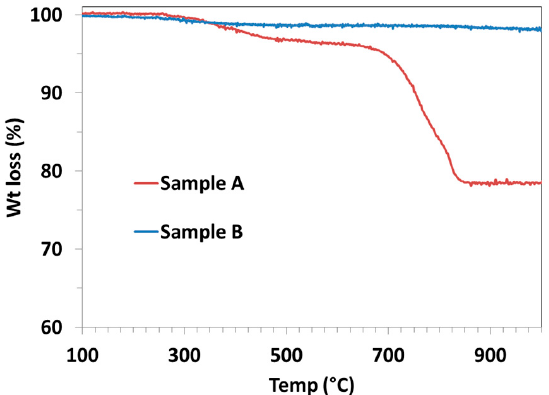
Figure 3. Particle size distribution of polishing waste samples. Sample B shows finer particles, whereas sample A shows coarser particles. Sample A is from plate glass polishing and sample B is from mirror polishing.